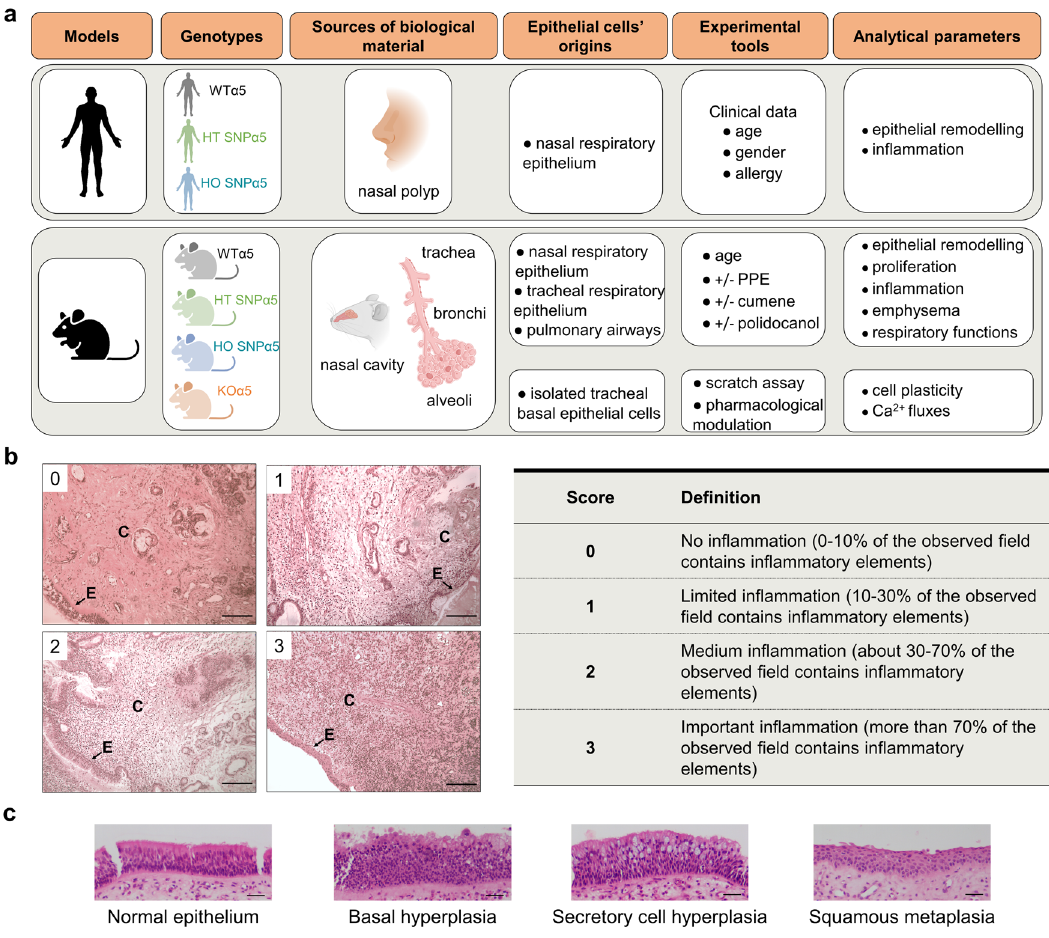
Fig. 1 α 5SNP expression and COPD-like remodeling in human airway epithelium. a Scheme highlighting the experimental systems (created with BioRender.com). In fl ammation of the lamina propria ( b ), and epithelial phenotypes ( c ) were quanti fi ed from 123 human nasal polyp samples on three micrographs by two histo-pathologists (bar = 100 µ m, E = epithelium, C = chorion). Effect of genotype, age, gender and, allergy/asthma on human